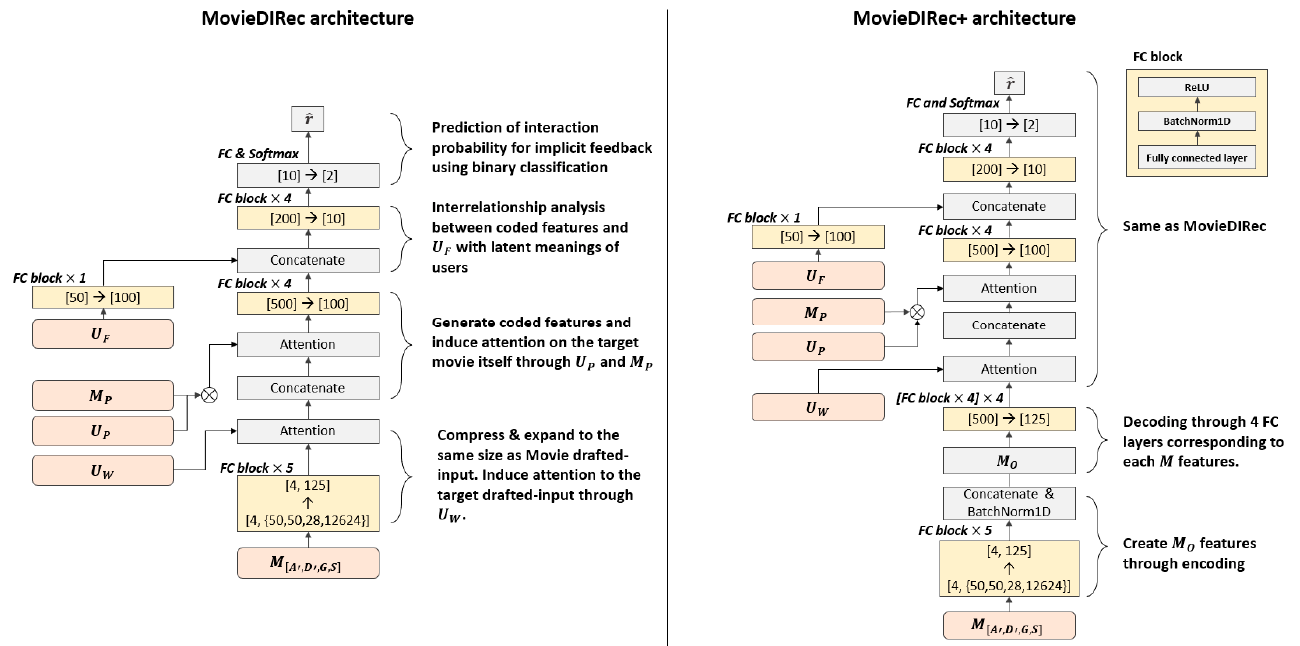
Figure 2. MovieDIRec ( left ) and MovieDIRec+ ( right ) model architecture. Yellow boxes mean FC layers, and red boxes mean Drafted-Input.